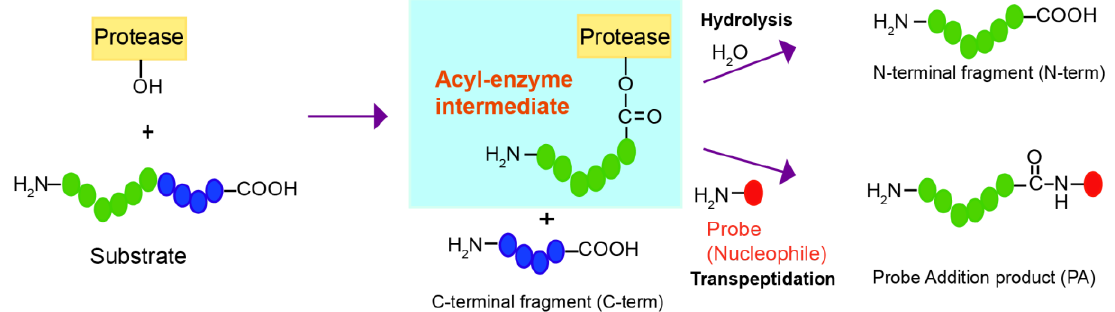
Figure 1. Reaction scheme of a protease that mediates either hydrolysis or transpeptidation of a peptide bond via the acyl-enzyme intermediate.